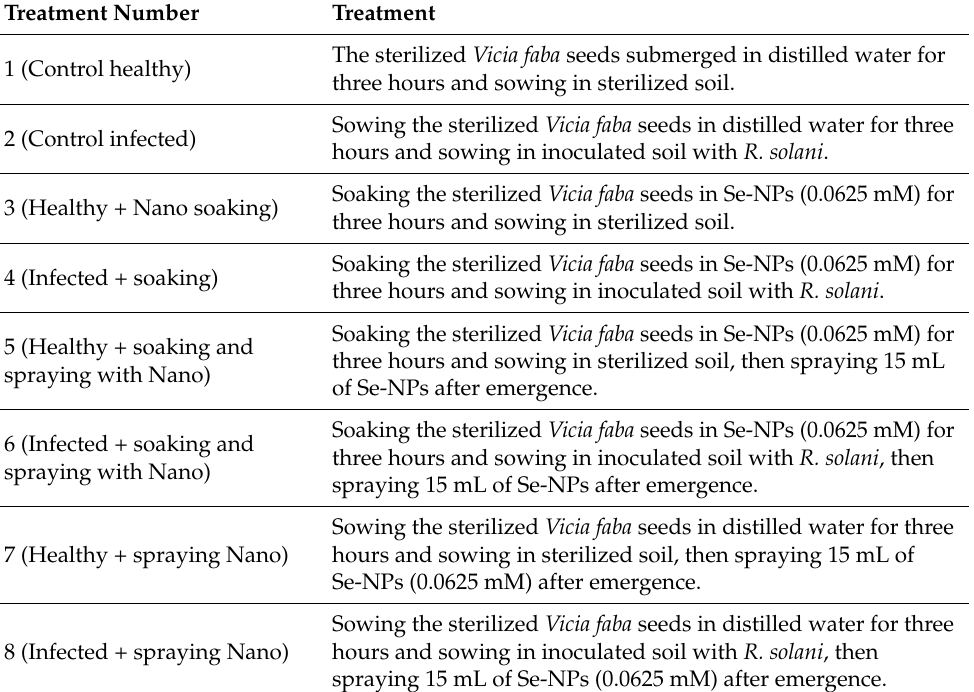
Table 1. Treatments used in this